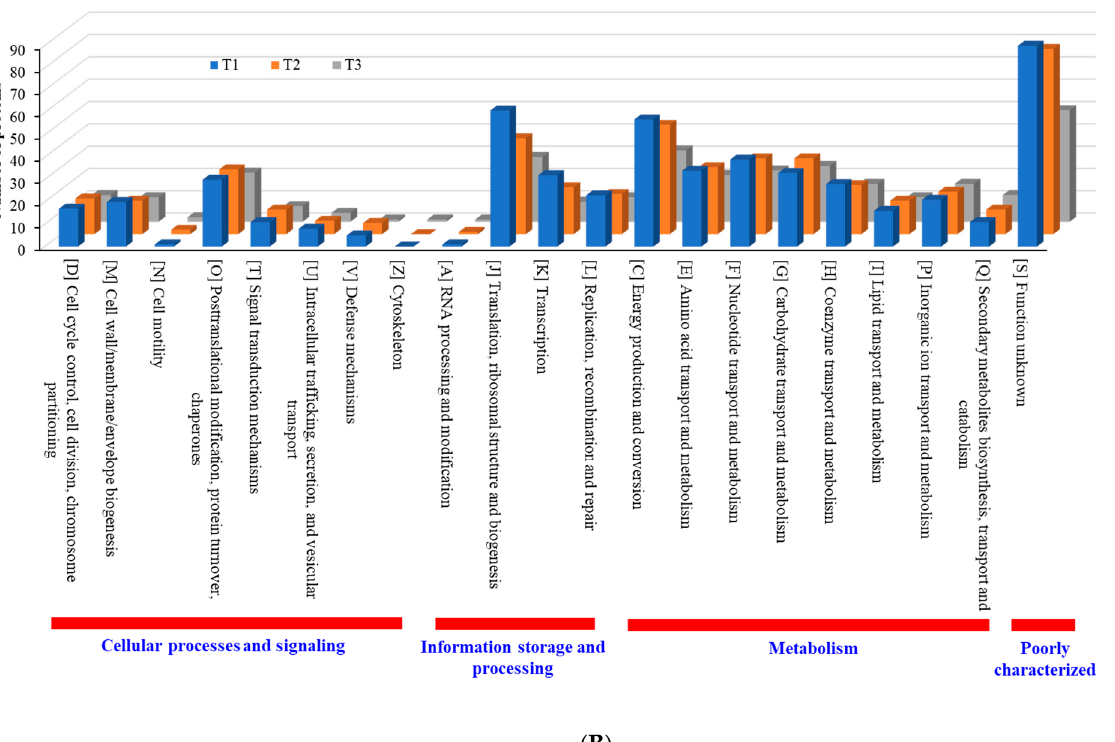
Figure 10. KEGG pathways of five major groups in differentially expressed proteins identified from S. epidermidis strain RP62A biofilms grown with sublethal MIC of TC. ( A ): upregulated proteins, ( B ): downregulated proteins, T1: 1/8 MIC, T2: 1/4 MIC, T3: 1/2 MIC.